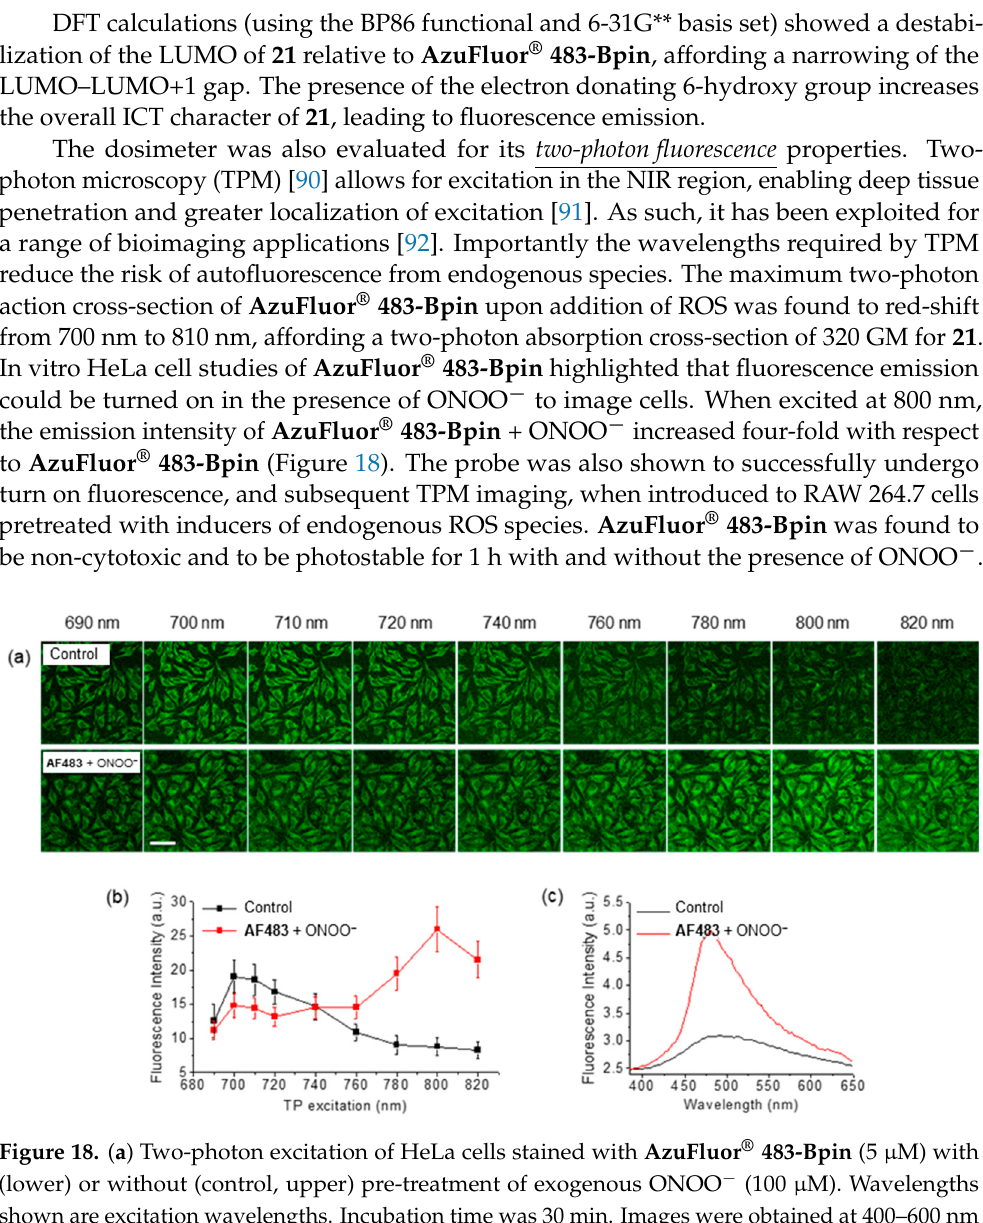
Table 1. Summary of fluorescent azulene-based sensors, dosimeters and imaging agents with accompanying references.